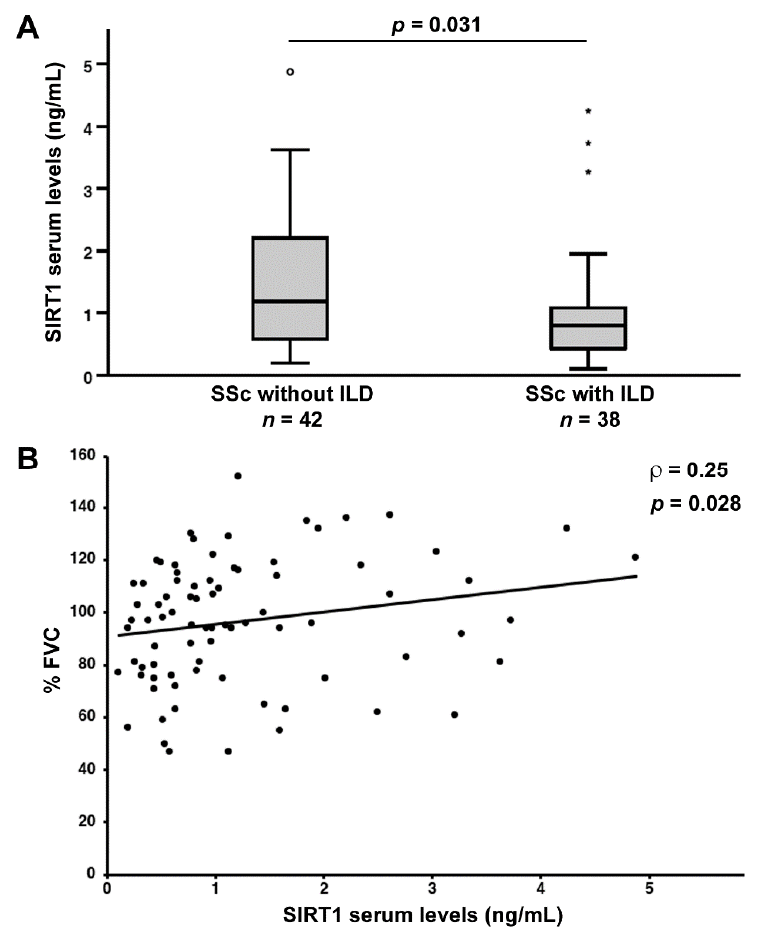
Figure 2. ( A ) Decreased serum levels of sirtuin 1 (SIRT1) in systemic sclerosis (SSc) patients with features of interstitial lung disease (ILD) on high ‐ resolution computed tomography scan of the chest. Data are presented as box plots. Each box denotes the 25th to 75th percentiles. Lines outside the boxes are the 10th and 90th percentiles. Lines inside the boxes denote the median, circles denote the outliers, and asterisks denote the extreme values. ( B ) Correlation of serum SIRT1 levels with pulmonary function measured as percentage forced vital capacity (%FVC) in patients with SSc. Data are displayed as scatterplot, where each dot represents a patient. Correlation coefficient ( ρ ) and p values are indicated.